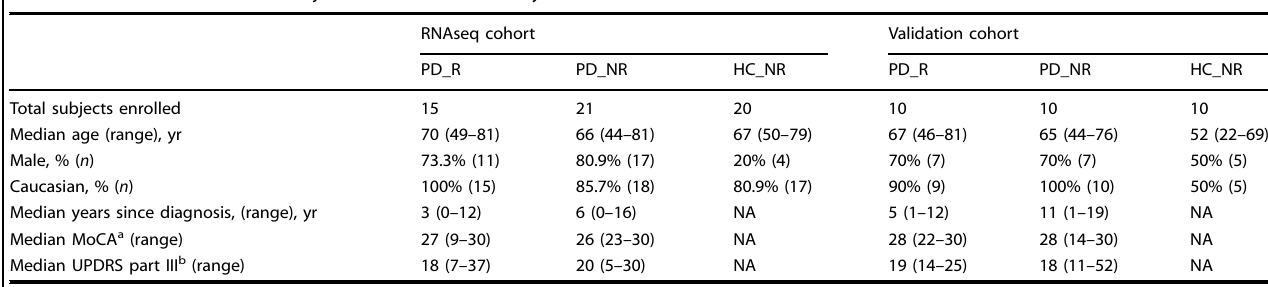
Table 2. Characteristics of the subjects enrolled in the